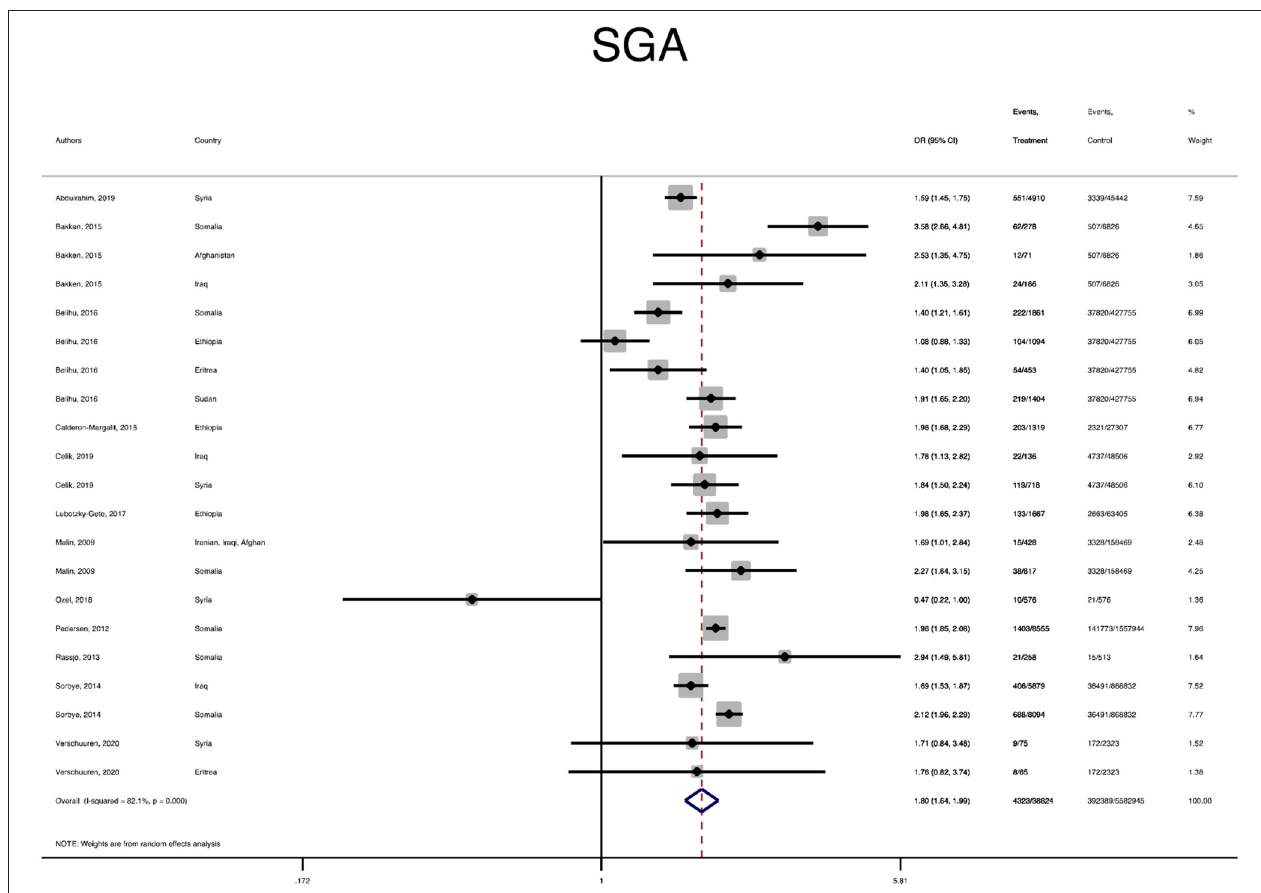
FIGURE 2 | A forest plot of the pooled odds ratio of small for gestational age (SGA) in the immigrant and native-origin